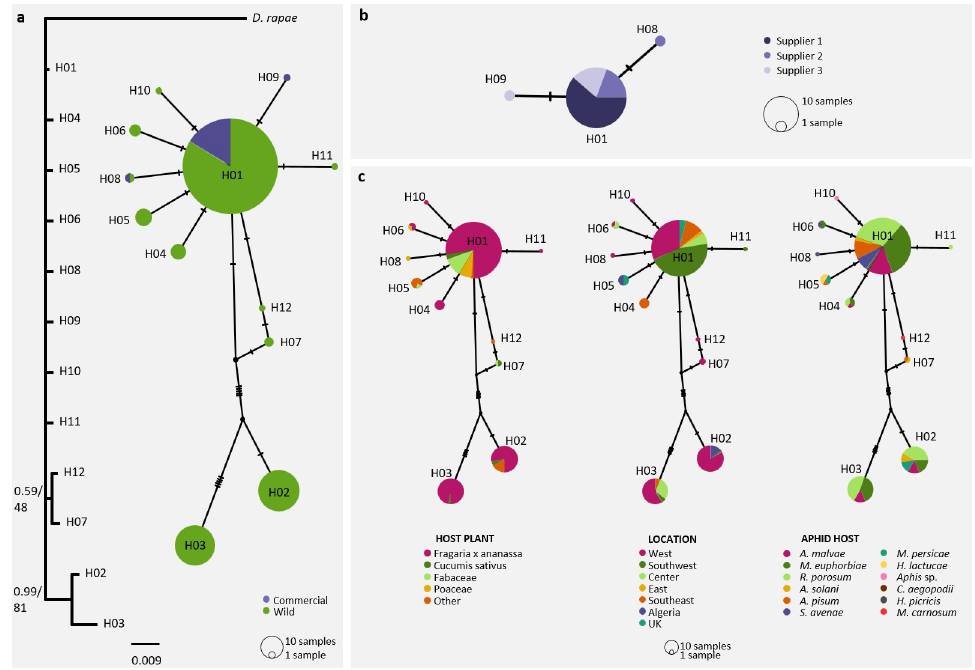
Fig 2. Genetic diversity of Aphidius ervi based on COI sequences. A : Bayesian inference (BI) / Maximum Likelihood (ML) tree and Median Joining haplotype network of commercial and ‘wild’ parasitoids sampled in strawberry greenhouses and other agroecosystems. On the tree, the first value at nodes shows posterior probability (BI analysis) and the second value shows bootstrap value (ML analysis). Scaling is expressed in the proportion of substituted bases per site. B : Median Joining network of commercial parasitoids according to the supplier. C : Median Joining network of ‘wild’ parasitoids according to the host plant, the location and the aphid host. In haplotype networks, hatch marks indicate a mutation between